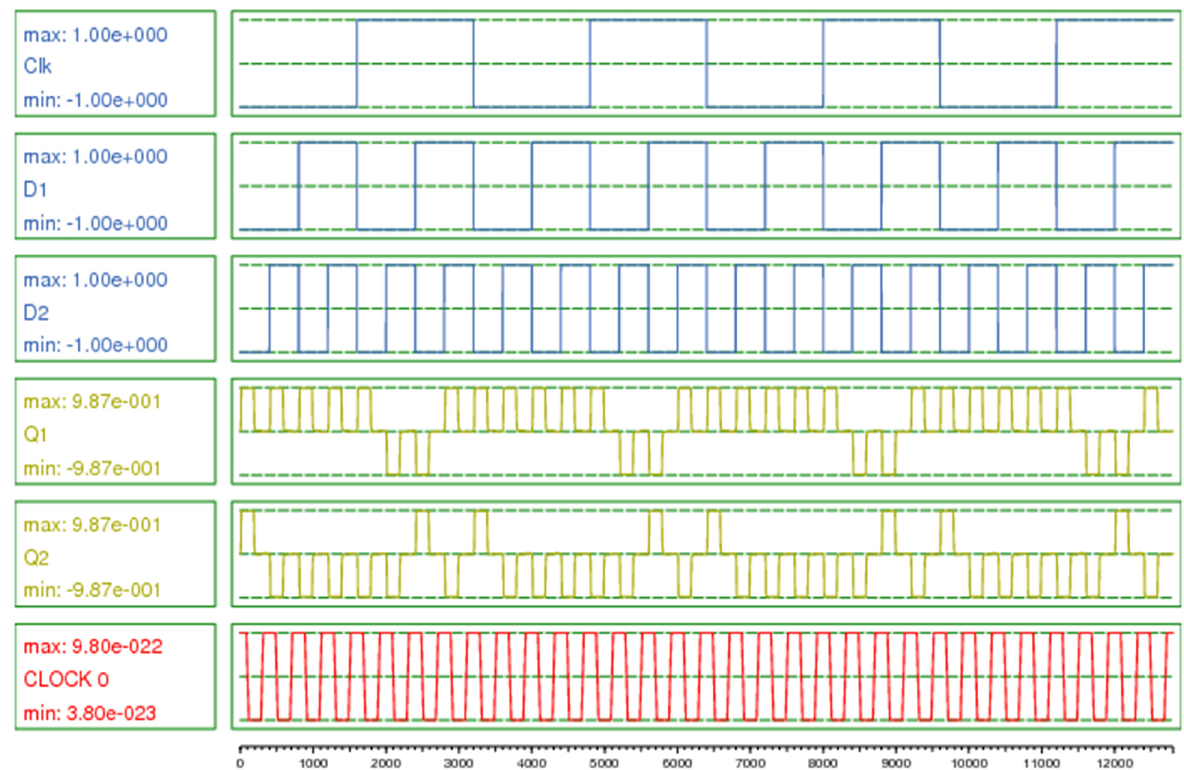
Figure 12. Simulation graph of 2-bit PIPO shift register.